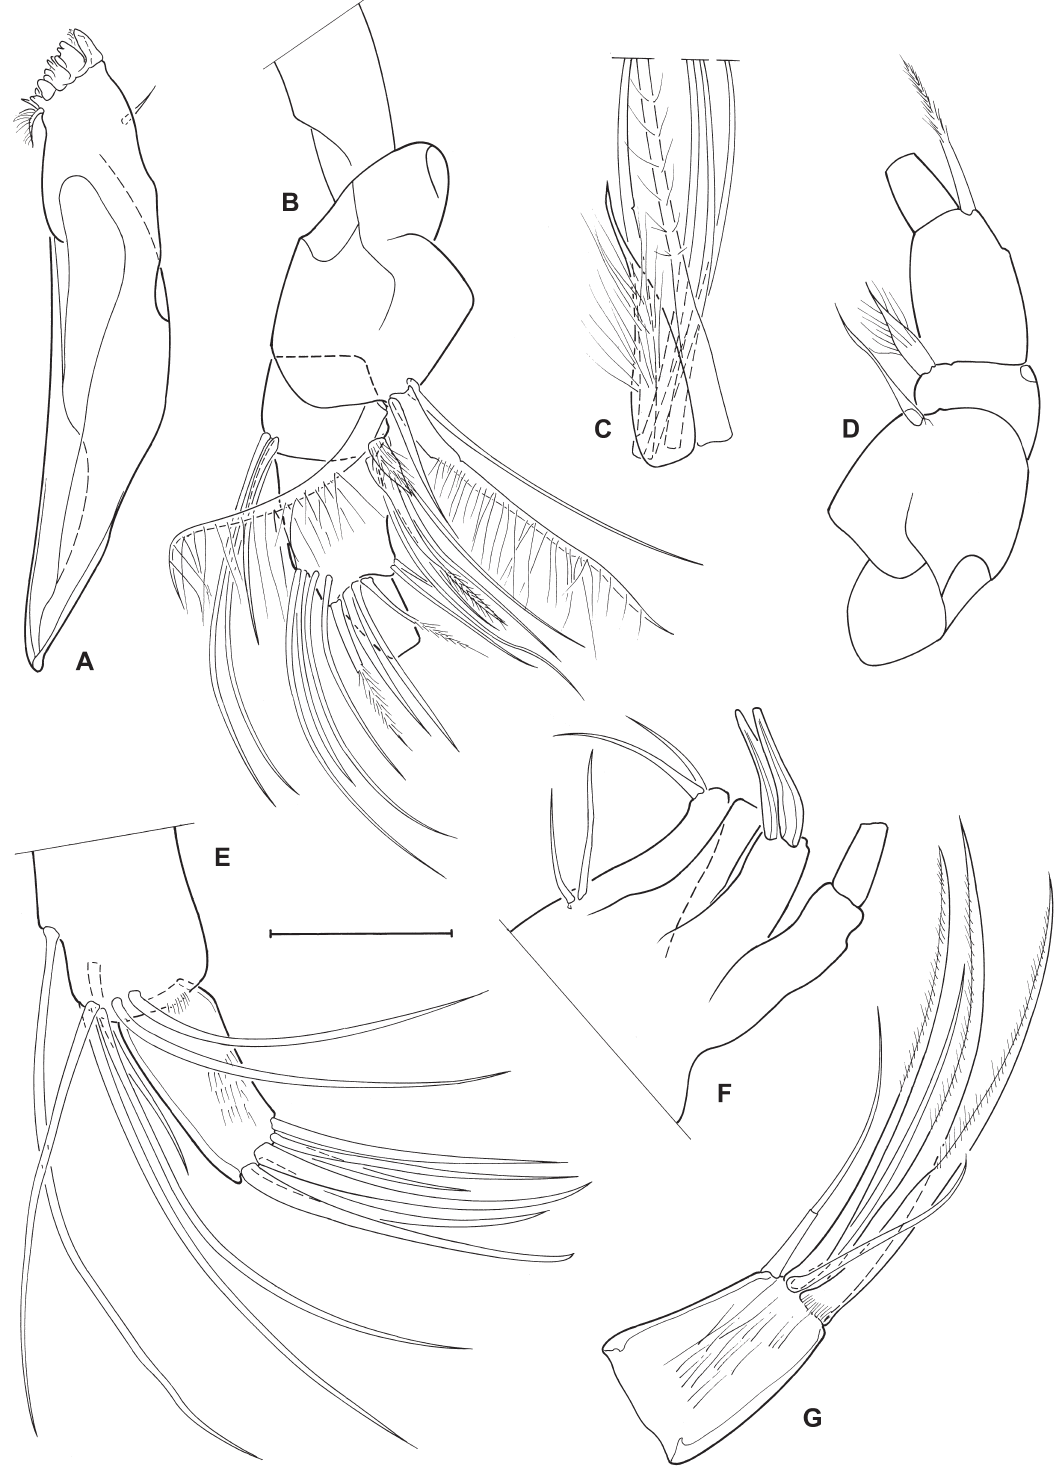
Fig. 7. Bennelongia cygnus sp. nov. (all from holotype ♂, WAM.C49370). A . Md-coxa. B . Md-palp. C . Md-palp. Detail of β-seta and accompanying setae. D . Md-palp, showing α, β, and γ-setae. E . Mx1-palp, distal chaetotaxy. F . Mx1, partial chaetotaxy. G . Md-palp, chaetotaxy of distal segment. Scales: A = 232 µm; B, D, F = 92 µm; C, E, G = 37